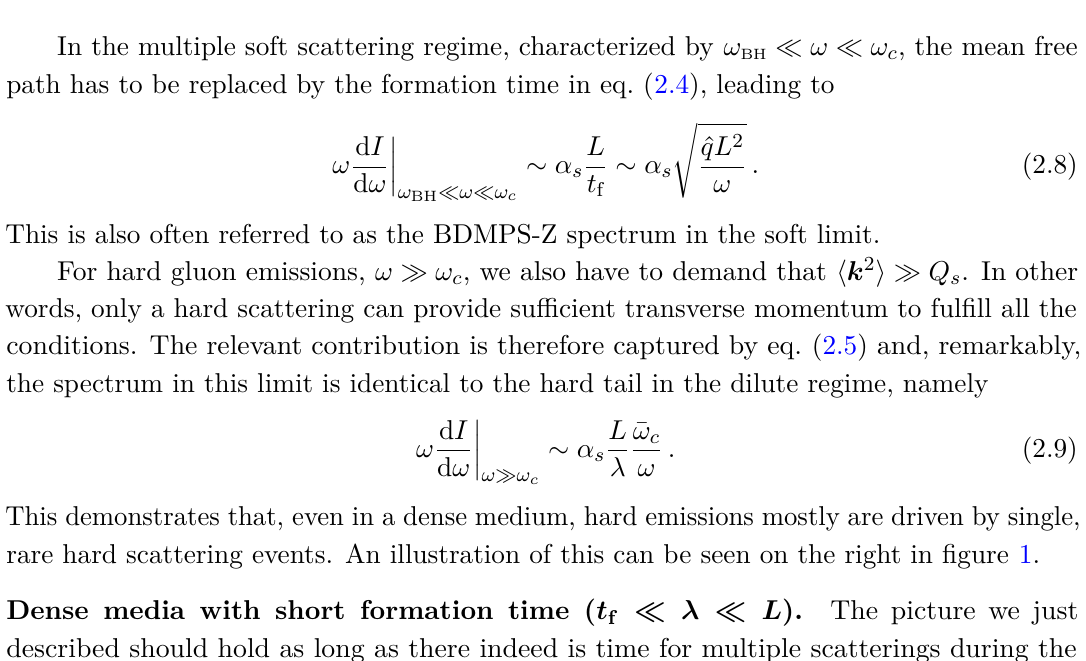
Figure 2 . A sketch of the spectrum of medium-induced gluons in a dilute medium L (cid:28) λ (left) and in a dense medium L (cid:29) λ